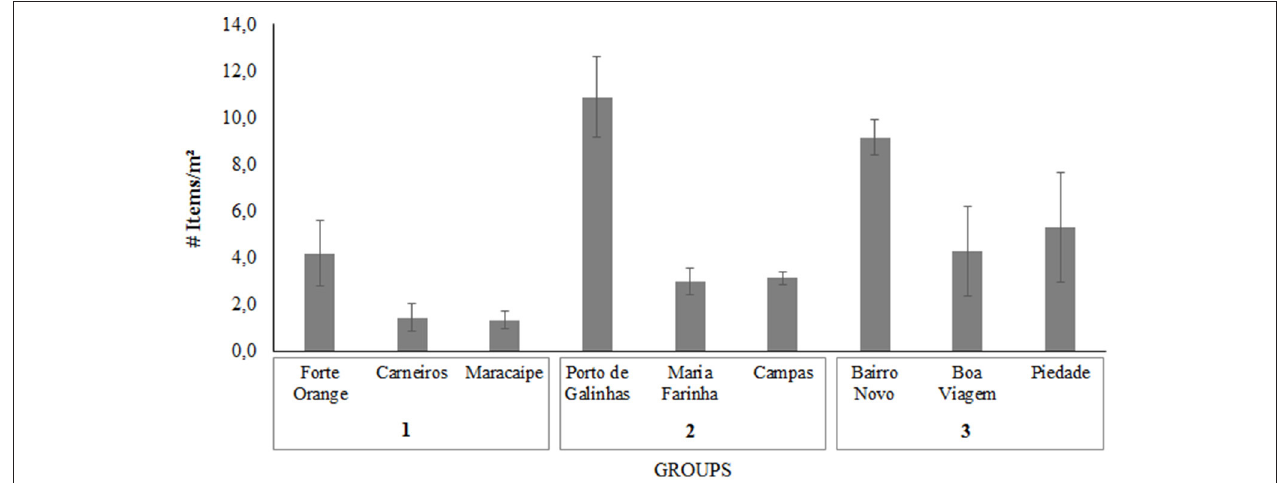
FIGURE 3 | Mean value and standard deviation of total items for each evaluated beach.